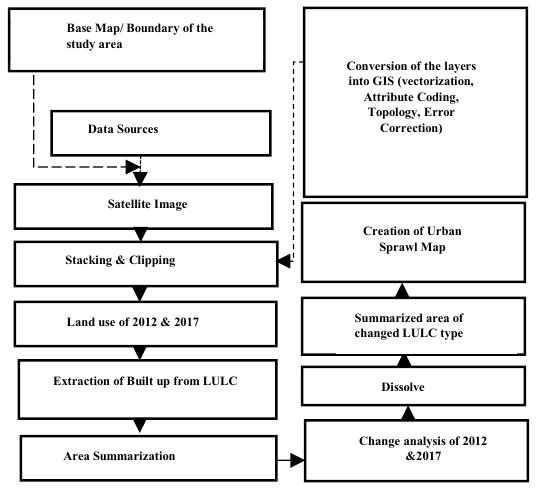
Figure 2 Scheme adopted for LULC change